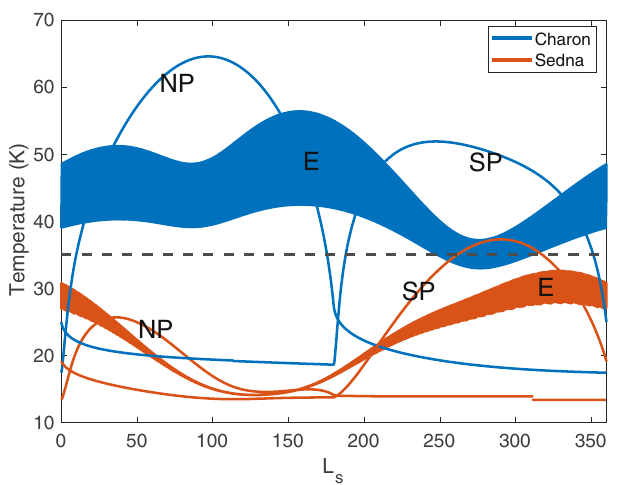
Fig. 4 Surface temperatures of Charon and Sedna. Charon surface temperatures (blue) at the north pole (NP), south pole (SP), and equator (E) over one Charon year, and Sedna surface temperatures (orange) at the same latitudes over one Sedna year assuming a 45° obliquity. Sedna surface temperatures rarely climb above 35 K (dashed line; temperature at which cold trapping of methane is effective) at any latitude or time of year, so methane ice would be stable at all locations across Sedna ’ s surface for long periods throughout its orbit and would have long periods of time throughout the Sedna year to be radiolytically processed into non-volatile methane products and eventually tholins at any latitude instead of solely at the poles like Charon (see Supplementary Fig.